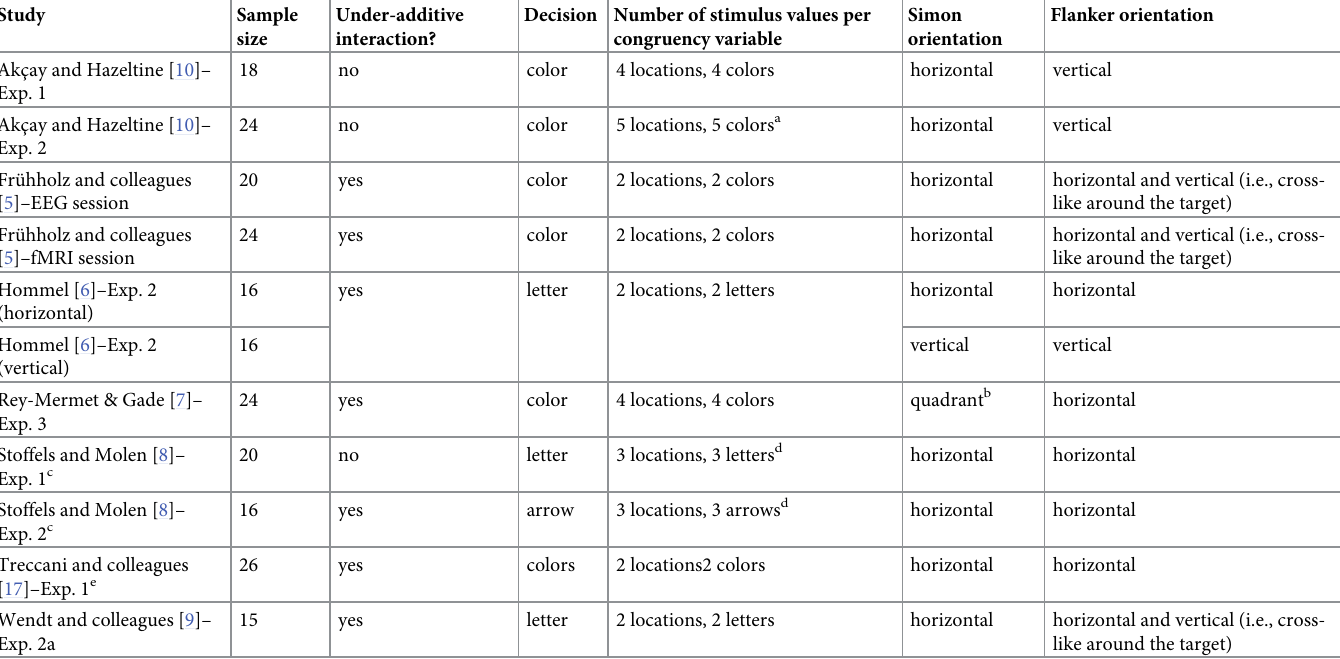
Table 1. Previous studies combining Simon and flanker congruency within the same